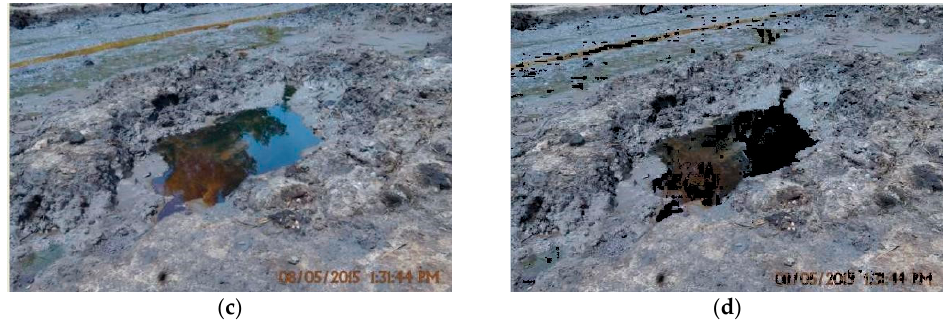
Figure 5. ( a ) Case image OS46; ( b ) Color Segmentation image for OS46; ( c ) Case Image OS66; ( d ) Color Segmentation image for OS66.